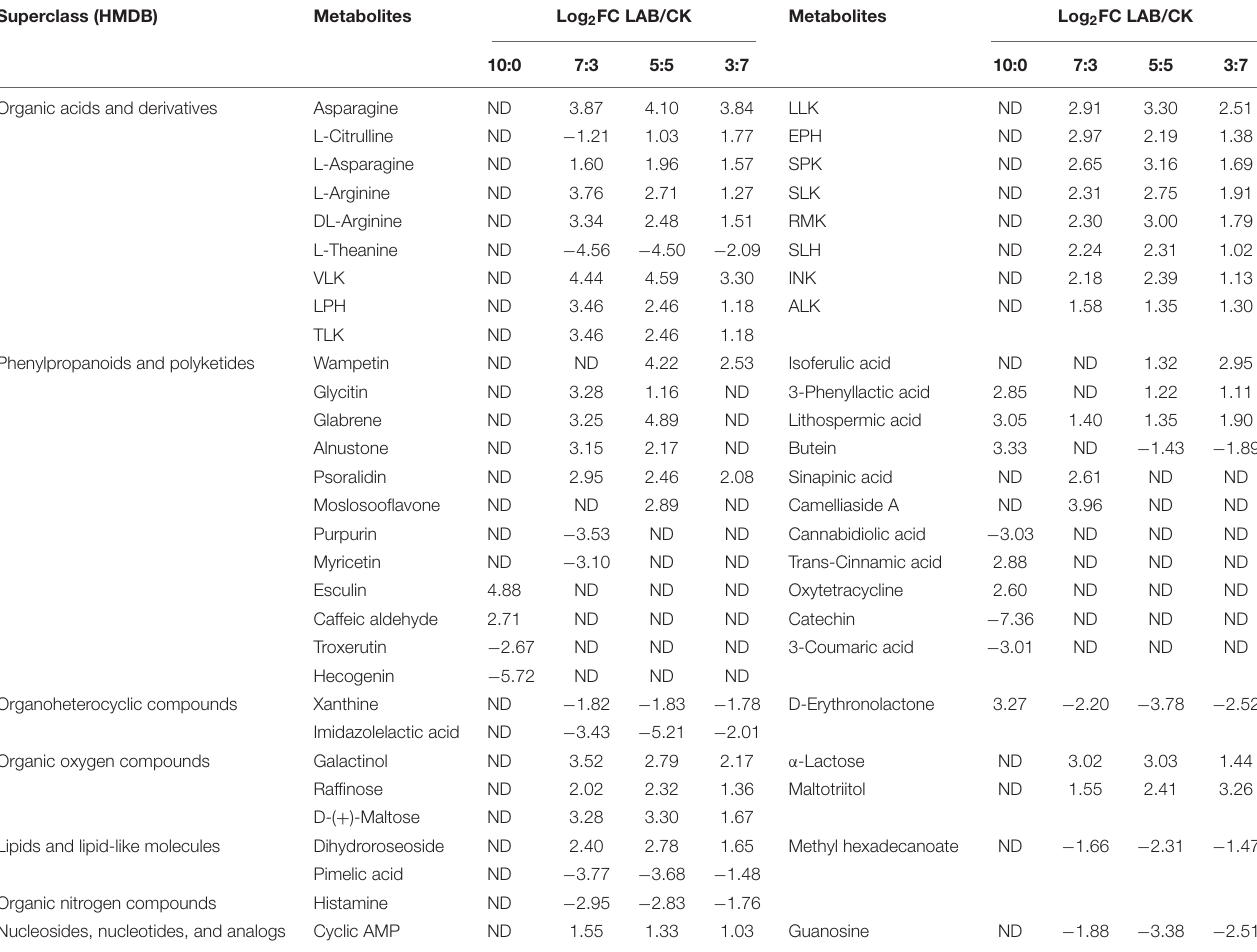
TABLE 3 | Fold changes of metabolites of SC-SS